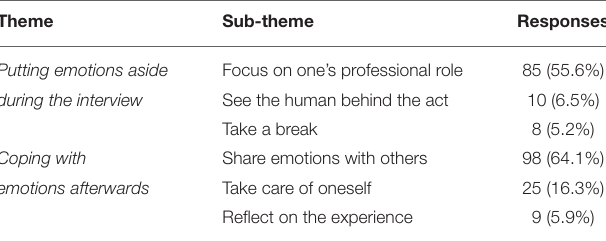
TABLE 8 | Overview of the thematic structure and the proportion of responses categorized into each sub-theme. ( n = 153 respondents).